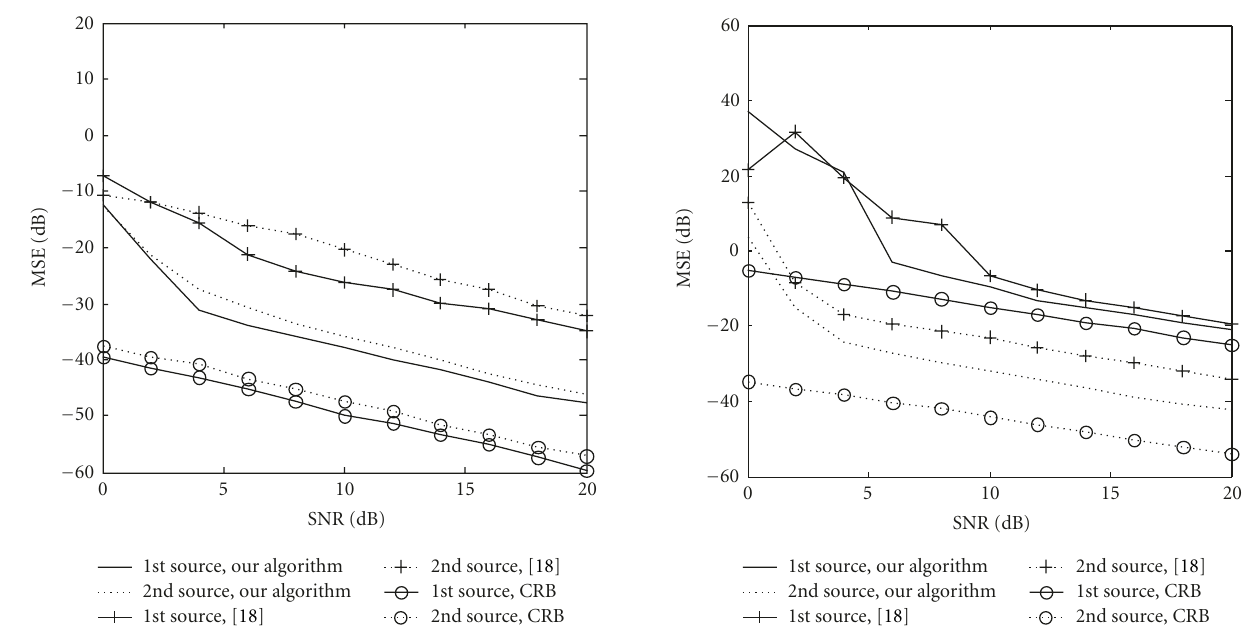
Figure 5: Estimation MSE of the ranges versus input SNR.